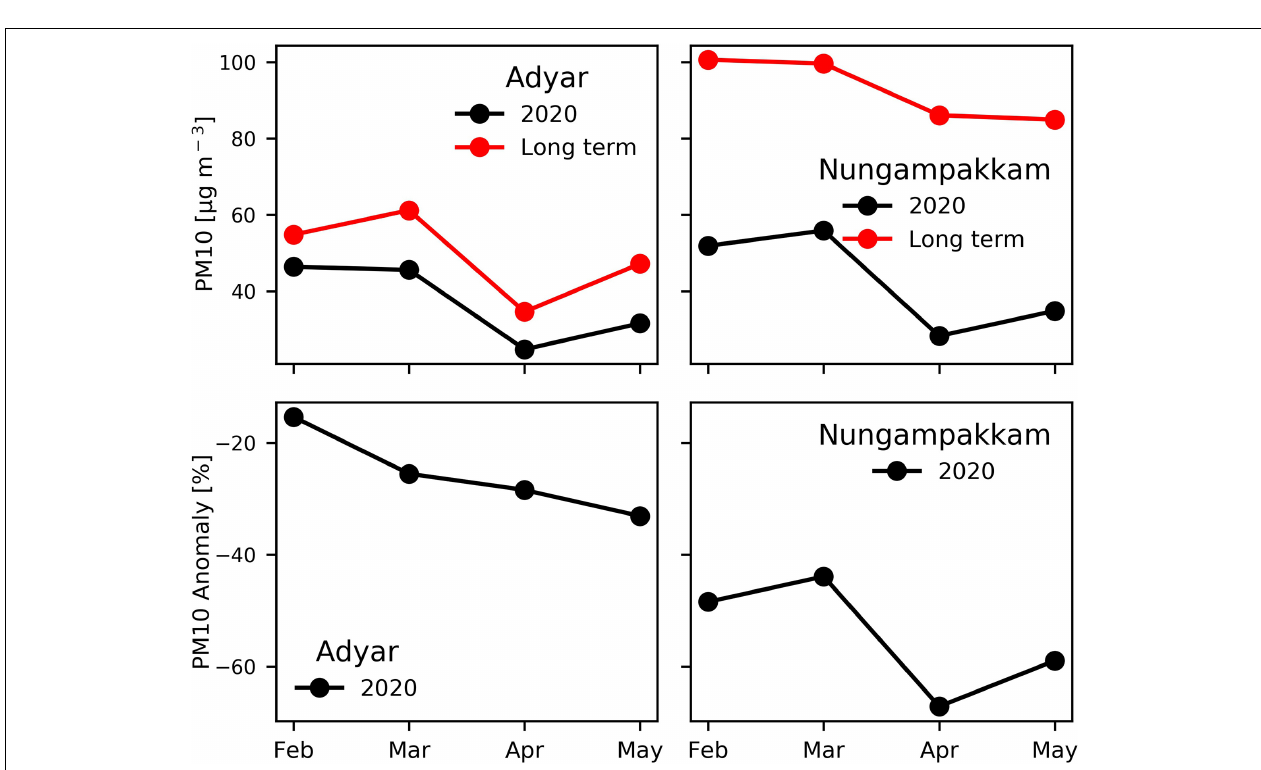
FIGURE 6 | Plots representing variations in monthly means and their percentage anomalies with long-term data of PM10 data at residential (Adyar), commercial (Nungampakkam), and industrial (Manali) zones.